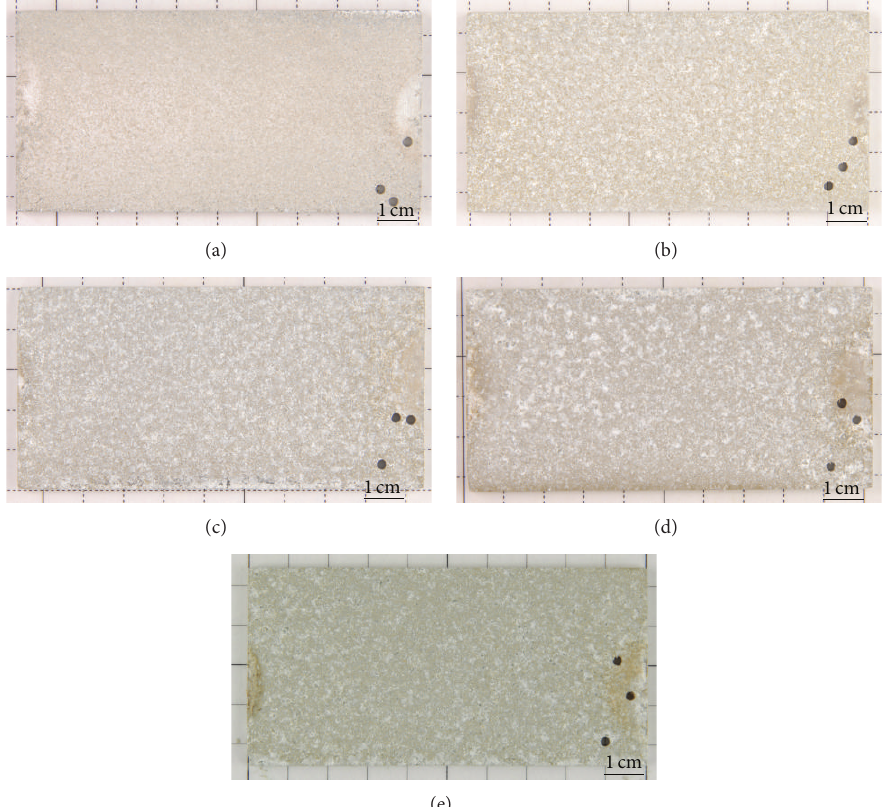
Figure 6: Surface appearances of the 2A12 aluminum alloy exposed for 1 month (a), 6 months (b), 12 months (c), 24 months (d), and 48 months